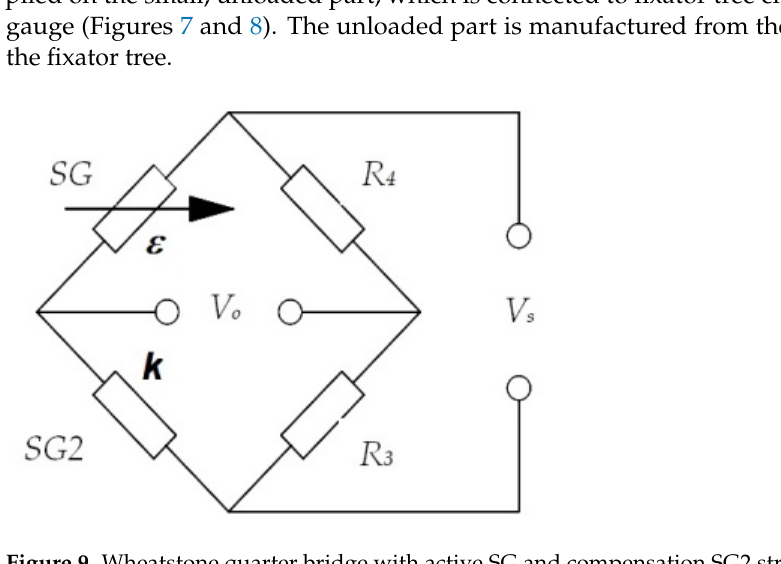
Figure 10. Comparative diagram of the principal stresses ( σ 1 on MP+) and ( σ 3 on MP − ).